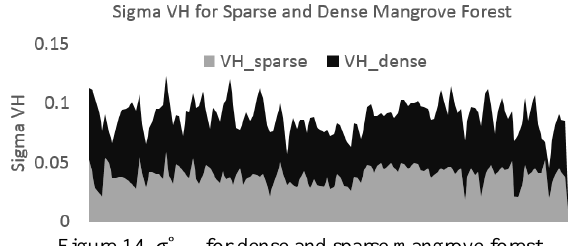
Figure 14. 𝜎˚ 𝑉𝐻 for dense and sparse mangrove